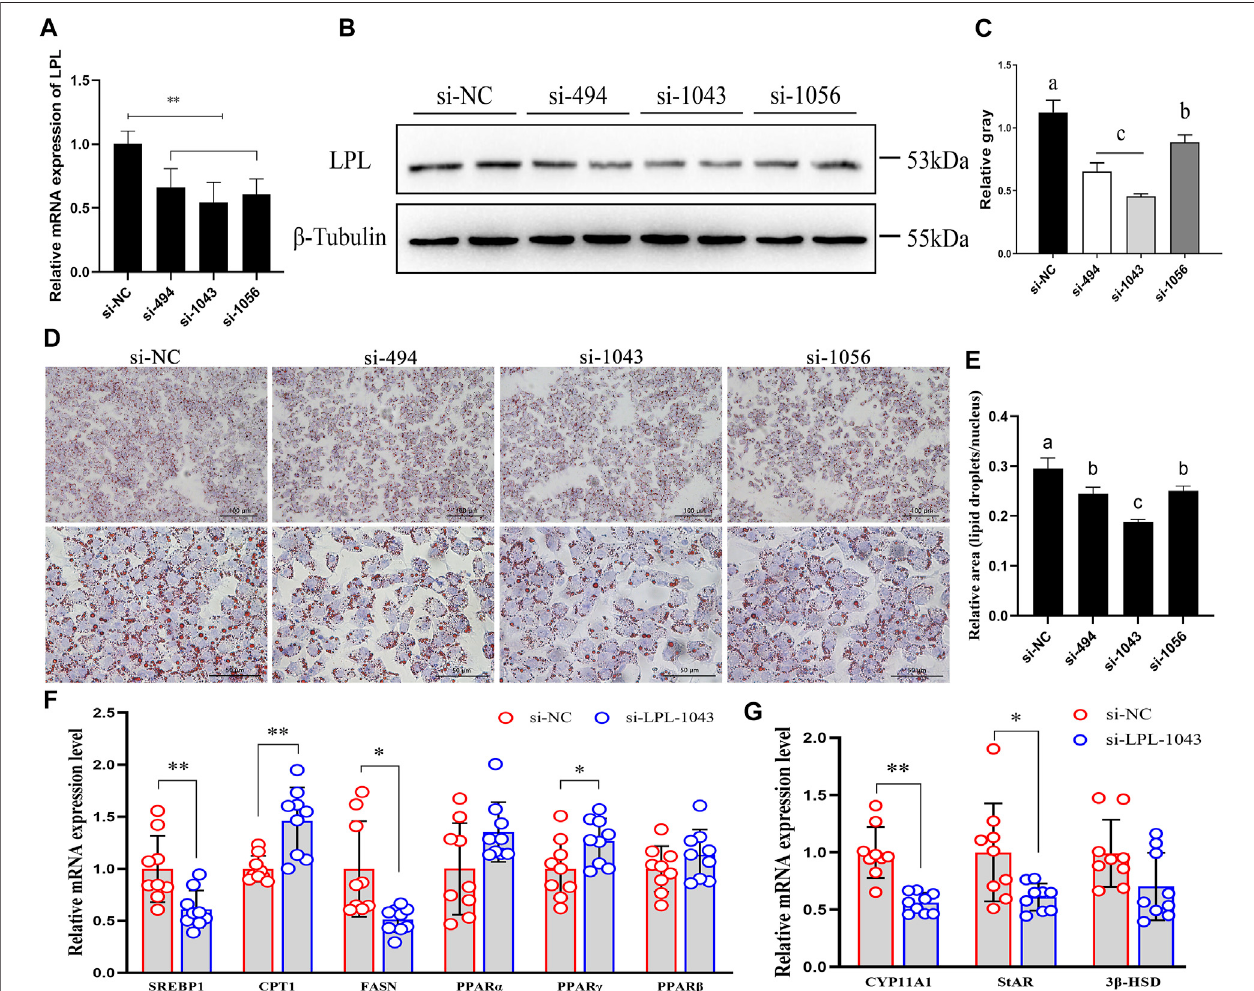
FIGURE 8 | LPL regulate granulosa cell lipid metabolism and steroidogenesis during sexual maturity. (A – C) Three small RNA interference (si-494, si-1043, and si- 1056) were used to knockdown the mRNA and protein expression of LPL. (D,E) After transfection of siRNAs, lipid droplets (LDs) accumulation in granulosa cells (GCs) was detected by oil red O staining (magni fi ed 200× and 600×). (F,G) LPL knockdown regulated the mRNA expression of lipid metabolism- and steroidogenesis-related genes. Data are presented as mean ± standard error (SE); * p < 0.05 and ** p < 0.01. Different lowercase letters indicate signi fi cant differences among the groups ( p <